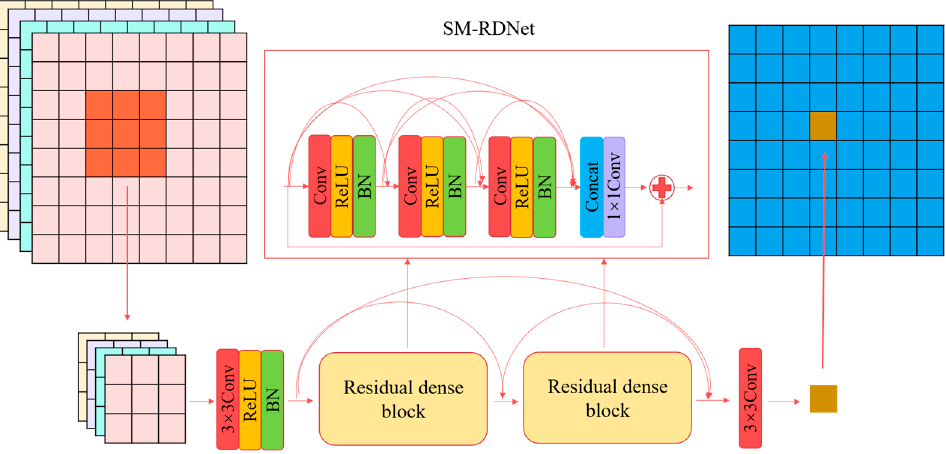
Figure 4. Network structure of SM-RDNet.